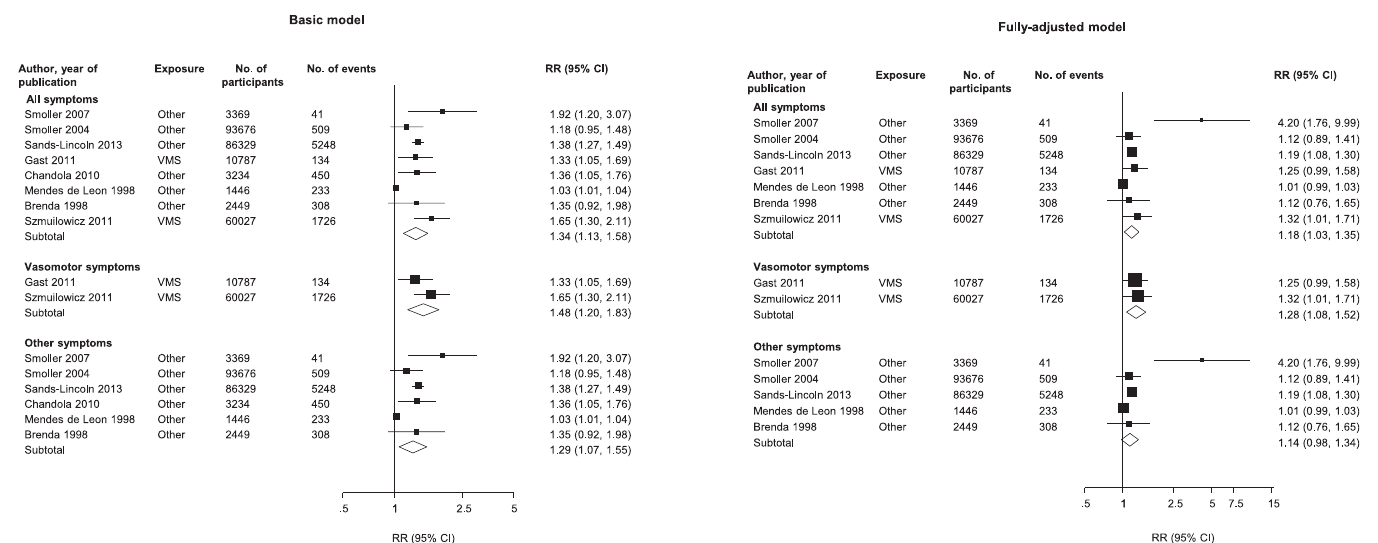
Fig 2. Relative risks of coronary heart disease associated with menopausal symptoms. Basic model: adjusted for age and non-established cardiovascular risk factors; Fully-adjusted model, adjusted for established cardiovascular risk factors and potential mediators. VMS, vasomotor symptoms; vasomotor symptoms include hot flashes and /or night sweats; All, includes vasomotor and other menopausal symptoms; Other, includes menopausal symptoms such as depression, insomnia, and panic attacks. Assessment of heterogeneity for basic model: All symptoms, X2 7 = 81.22, I2 = 91%, 85 to 95%; P < 0.001; vasomotor symptoms, X2 1 = 1.55, I2 = 35%; P = 0.213; other symptoms, X2 5 = 63.48, I2 = 92%, 86 to 96%; P < 0.001. Assessment of heterogeneity for fully-adjusted model: All symptoms, X2 6 = 29.20, I2 = 79%, 58 to 90%; P < 0.001; vasomotor symptoms, X2 1 = 0.09, I2 = 0%; P = 0.762; other symptoms, X2 4 = 22.63, I2 = 82%, 59 to 92%; P < 0.001.